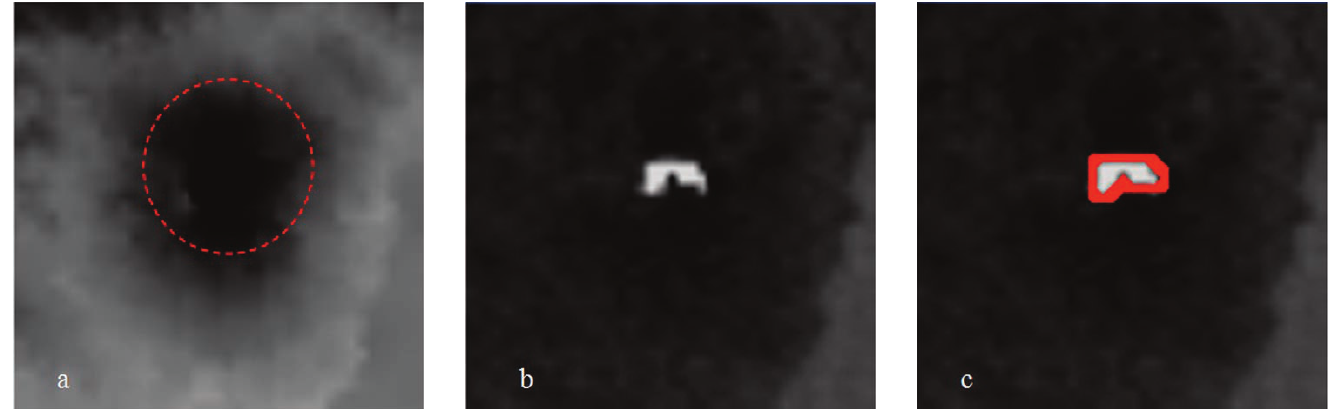
Figure 8. Mount Etna AVHRR image of October 30, 2006. (a) Crater area (darkest pixels), characterized by an almost uniform distribution of basaltic flows. (b) Thermal anomaly in band 3. (c) Thermal anomaly contour for the background-temperature estimation from the non-active pixels surrounding the thermal